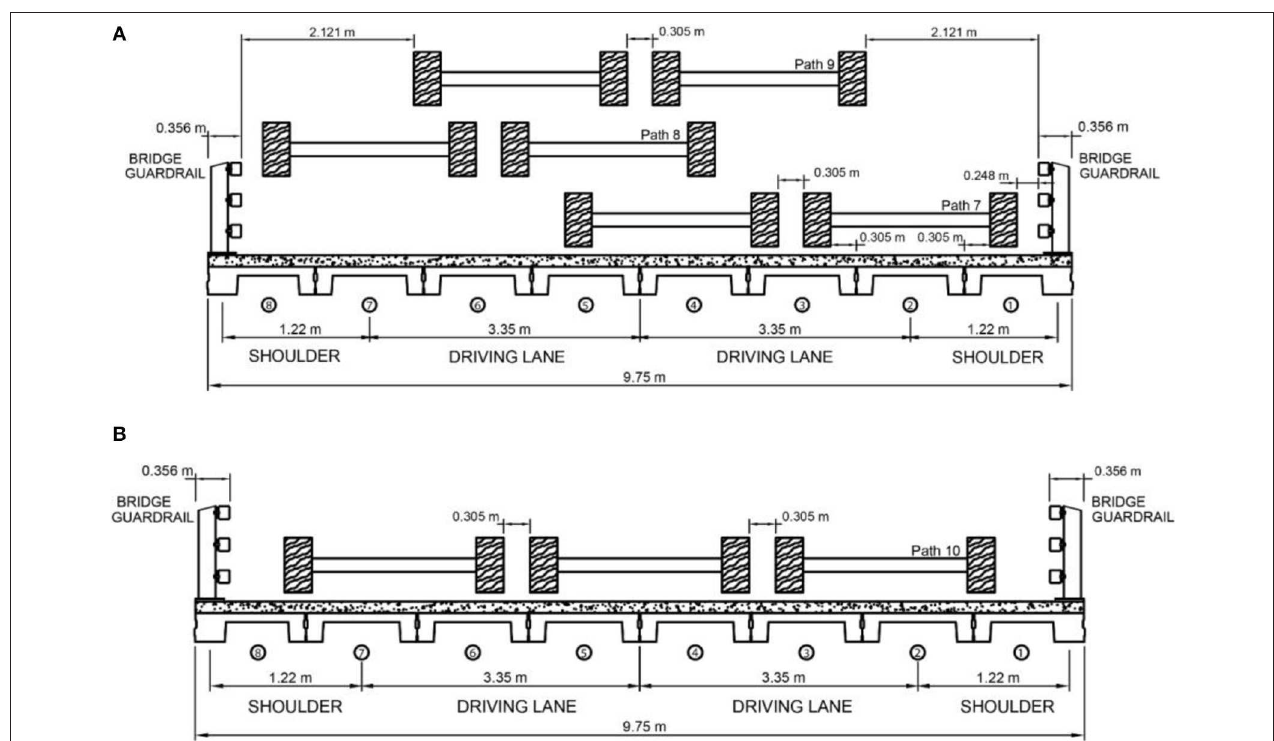
FIGURE 8 | (A) Double truck side-by-side transverse load paths 7, 8, and 9, (B) Triple truck side-by-side transverse load path 10.